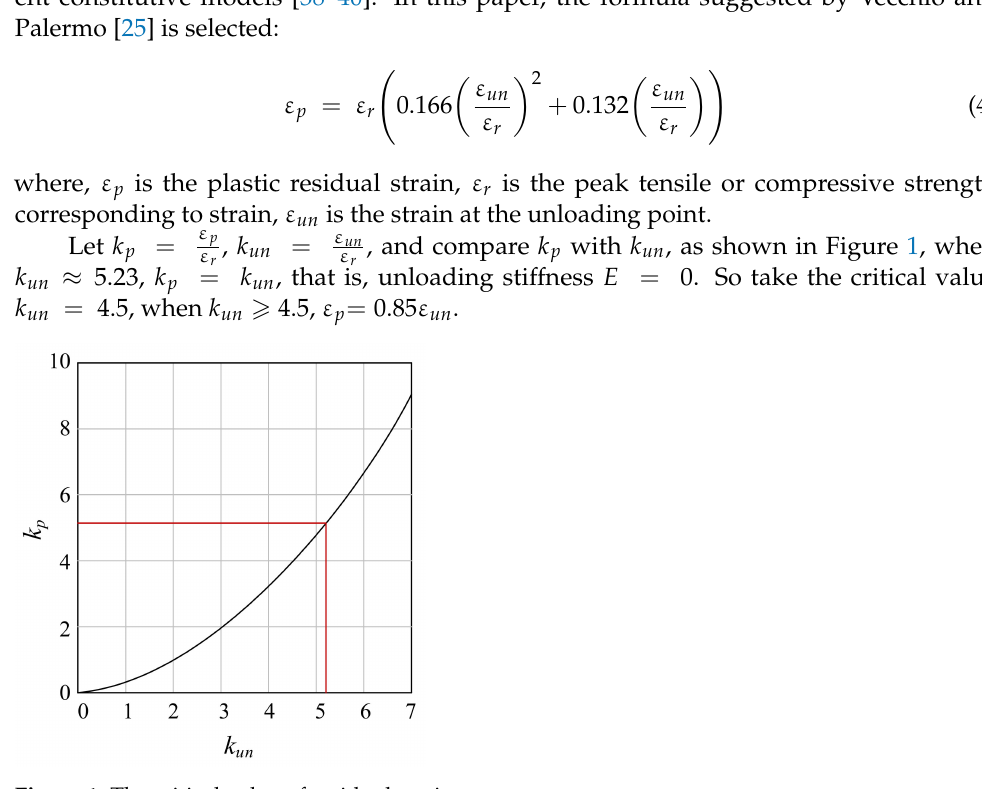
Figure 1. The critical value of residual